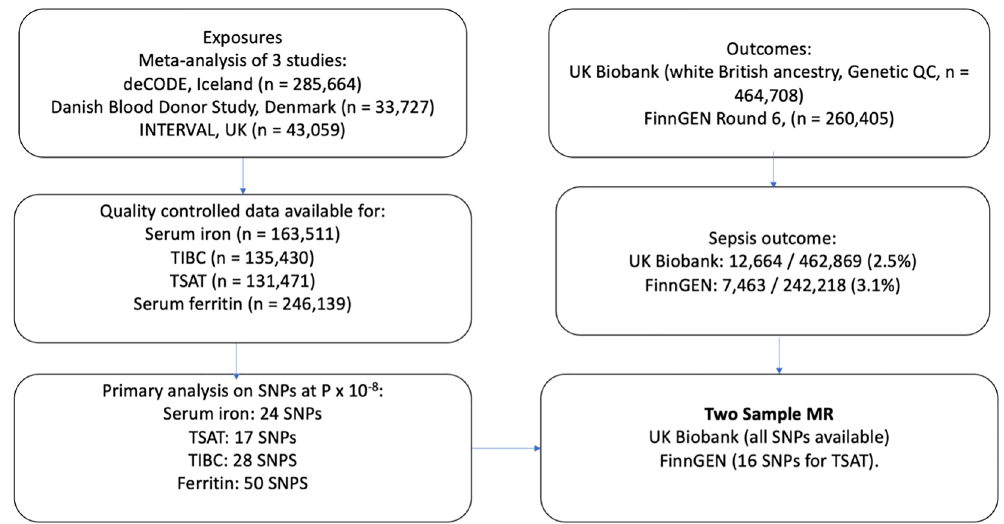
Figure 3. Flow chart of included studies, exposures, and